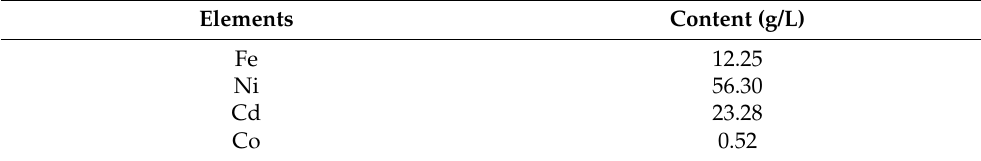
Table 1. The major metal ion concentrations in simulated